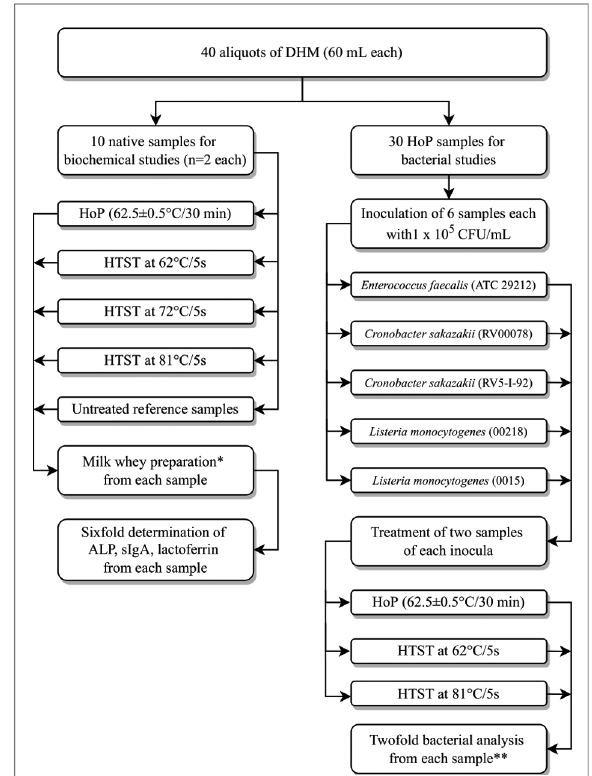
FIGURE 1 Study fl ow chart: processing of human milk probes. ALP=alkaline phosphatase; CFU=colony forming units; DHM=donor human milk, HoP=Holder pasteurisation; HTST=high temperature short time treatment; sIgA=secretory immunoglobulin A. *Preparation of milk whey: From samples 10 ml aliquots were centrifuged at 600 g for 10 min, the resulting aqueous layer was centrifuged again at 600 g for 10 min and the resulting whey supernatant was centrifuged at 2,500 g for 10 min and the resultant supernatant was then fi ltrated with a 0.45 μ m with syringe fi lter. **Lower limit of detection<10 cfu/ml, inoculated but not heat-treated aliquots were also